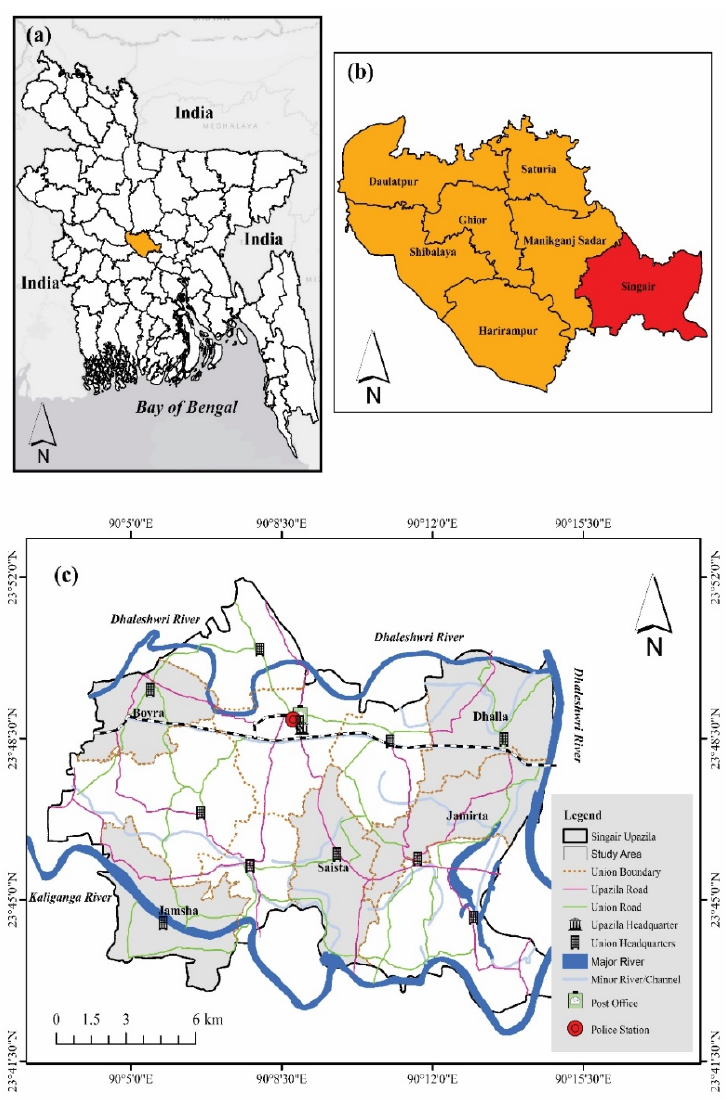
Figure 2. Location of the study area: ( a ) Manikganj district in Bangladesh; ( b ) Singair Upazila in Manikganj; and ( c ) selected unions in Singair.